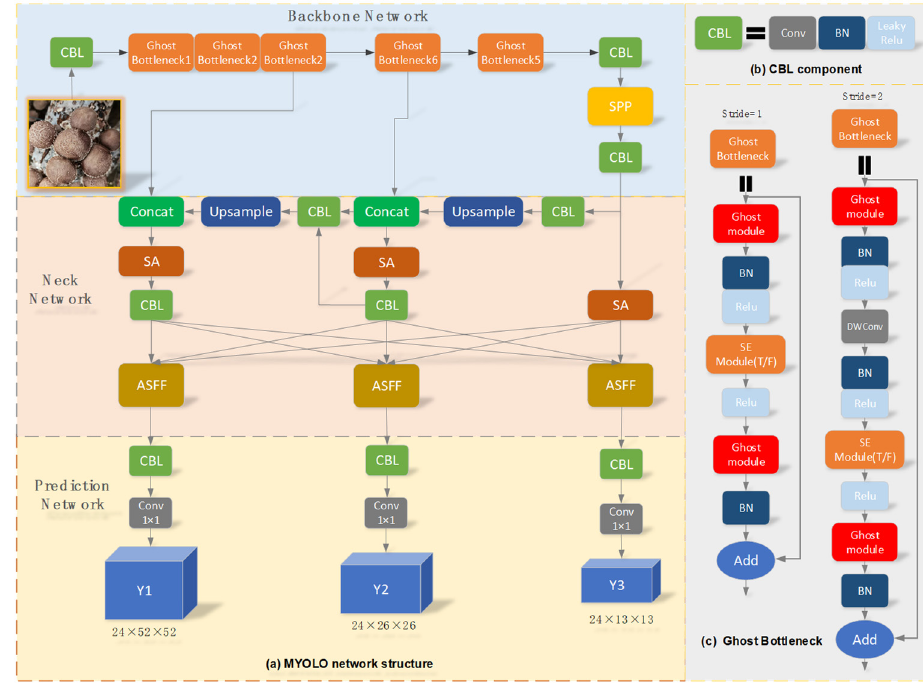
Figure 4. MYOLO network structure.